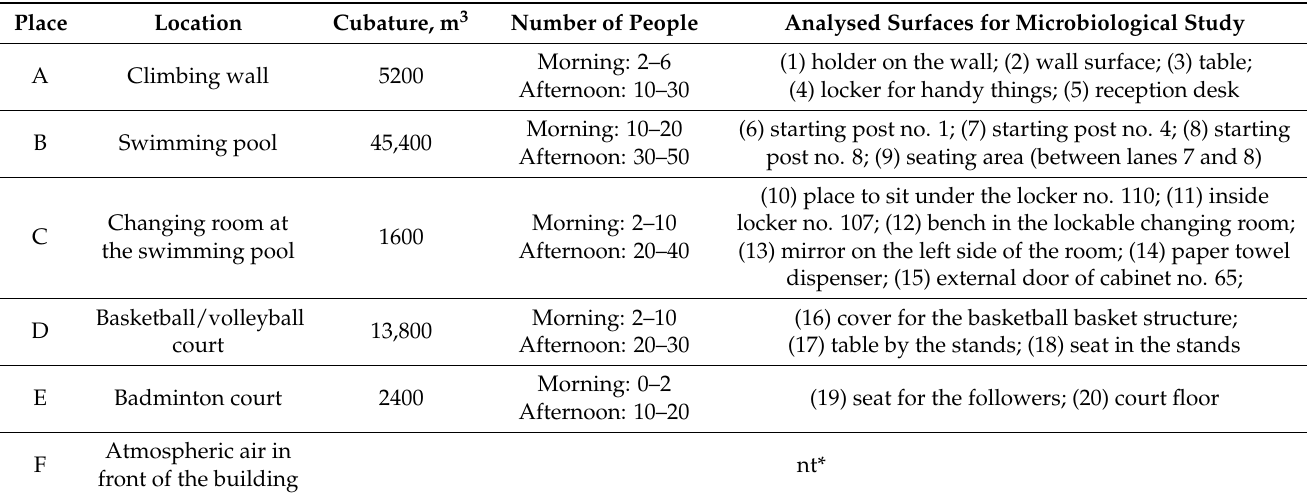
Table 1. Characteristics of the analysed sports